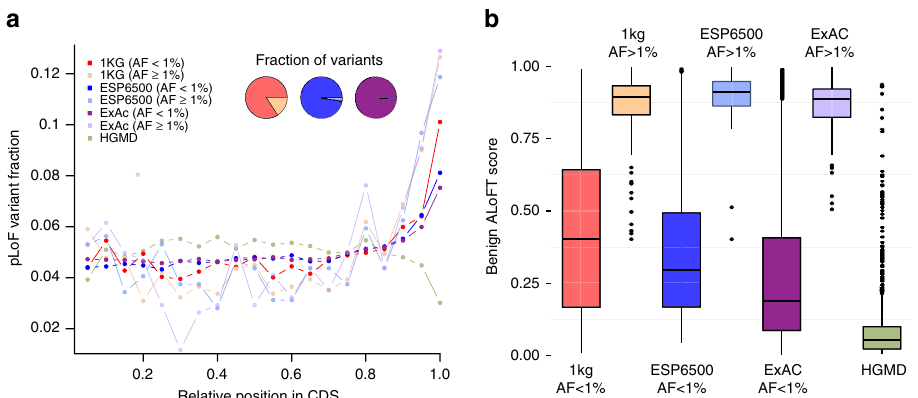
Fig. 7 pLoFs in last exons. a Position of premature stop variants in coding transcripts. Compared to HGMD variants, both common and rare 1KG, ESP6500, and ExAC variants are enriched in the last 5% of the coding sequence. AF, allele frequency, pLoF, putative loss-of-function variant, and CDS, coding sequence. Variants at allele frequency < 1% are considered to be rare variants. Variants with at least 1% allele frequency are considered common. b Predicted benign scores for premature stop variants in the last coding exons. In the box plots , the center line represents the median value of the data, the box goes from the fi rst quartile to the third quartile. The lower whisker goes from Q1 to the smallest non-outlier in the data set, and the upper whisker goes from Q3 to the largest non-outlier in the data set. Outliers are indicated by the plotted points . Training variants are excluded in this plot